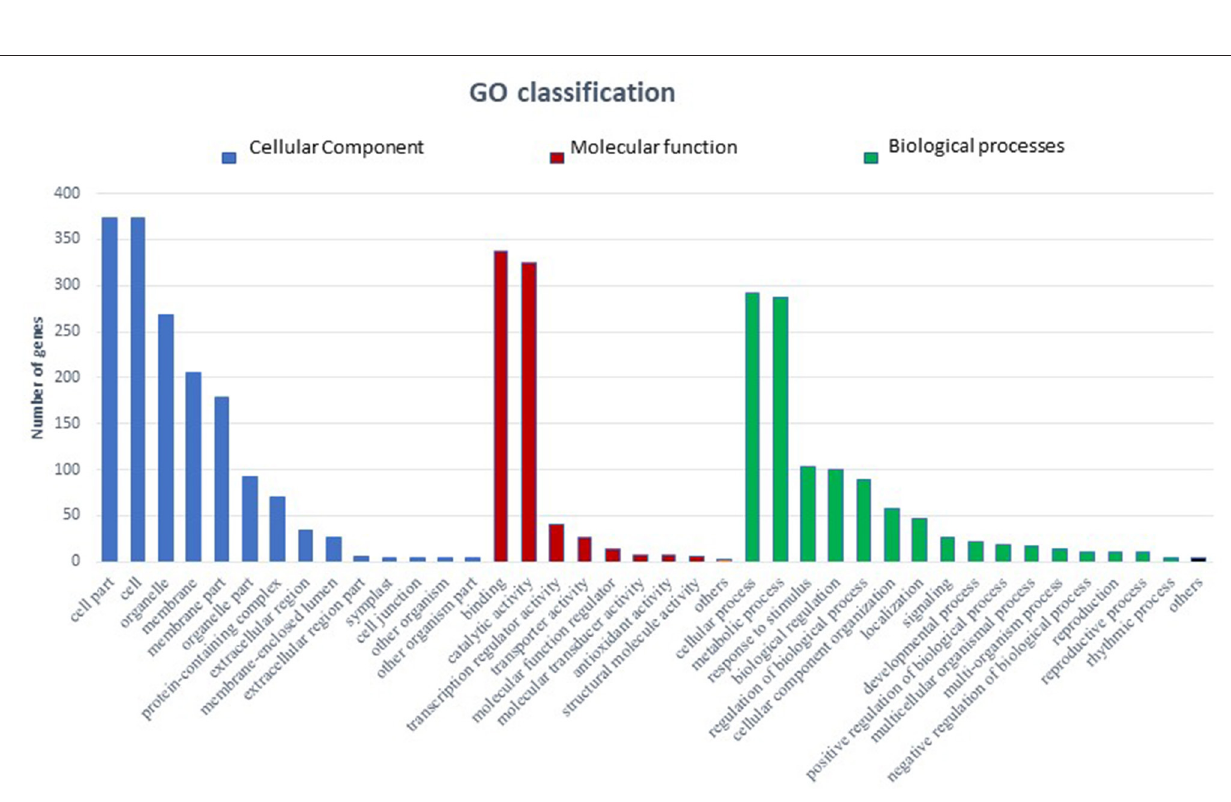
Frontiers in Plant Science |